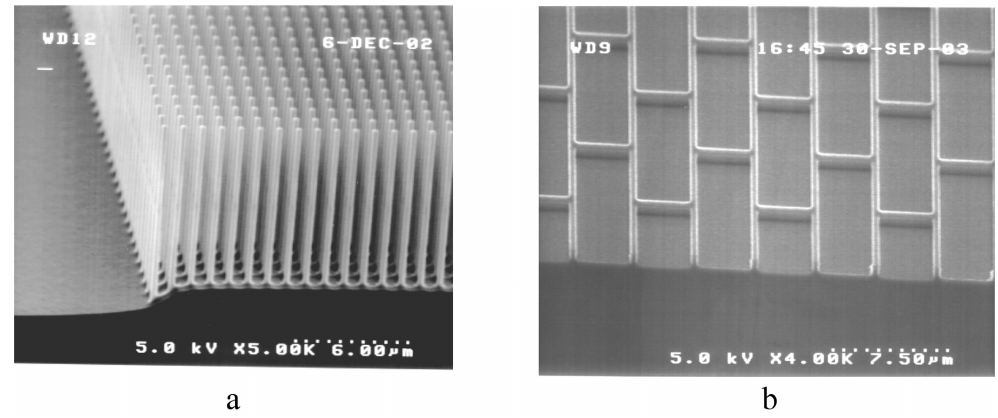
Figure 12. ( a ) SEM image of silicon nanograss; ( b ) SEM image of silicon nanobricks. From Henoch et al. [54].